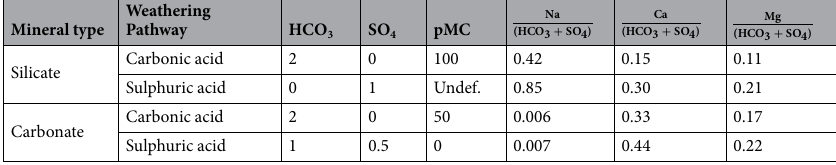
Table 1. Theoretical stoichiometries of weathering reactions and their DI 14 C fingerprints. Bicarbonate and sulphate concentrations normalised to one silicate or carbonate mineral unit (Ca, Mg, 2Na, 2K)SiO 3 or (Ca, Mg, 2Na, 2K)CO